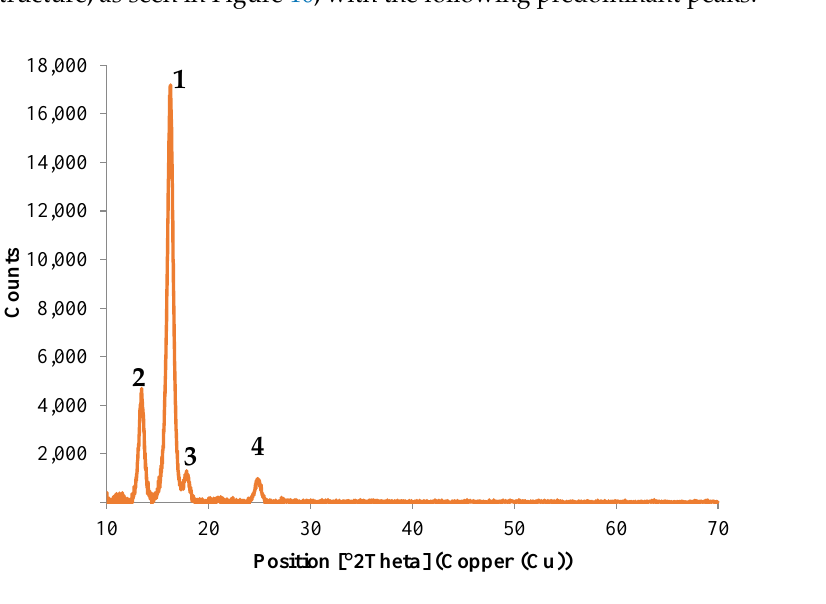
Figure 11. XRD analysis for P2 sample. 3.4. Highlighting the Biocidal Activity of an Arboblend V2 Nature Sample Obtained by Injection into the Mold of Granules Coated with Silver Nanoparticles After 72 h, in which the samples and controls were incubated at 37 °C, 1ml of cell suspension was taken from each sample and control for both test bacterial species. Serial dilutions were performed (10 −1 – 10 −8 ) in sterile saline. From dilutions 10 −8 – 10 −4 , 0.1ml of cell